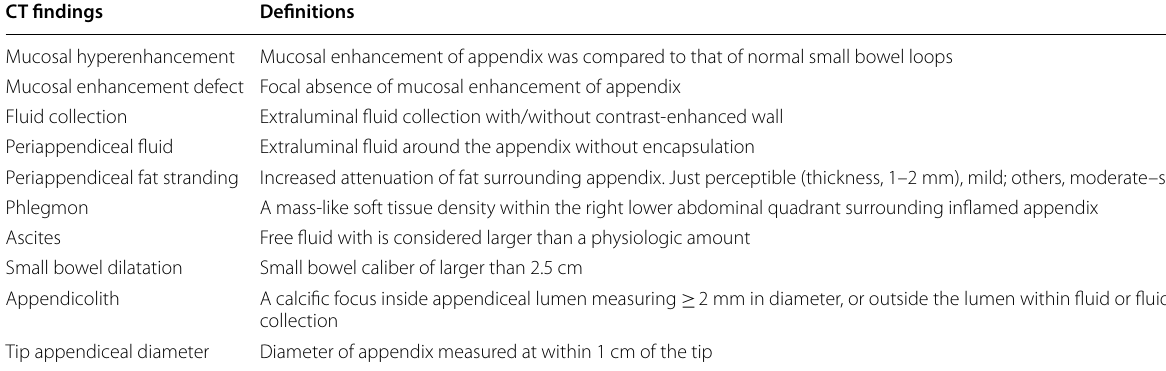
Table 1 Definitions of CT